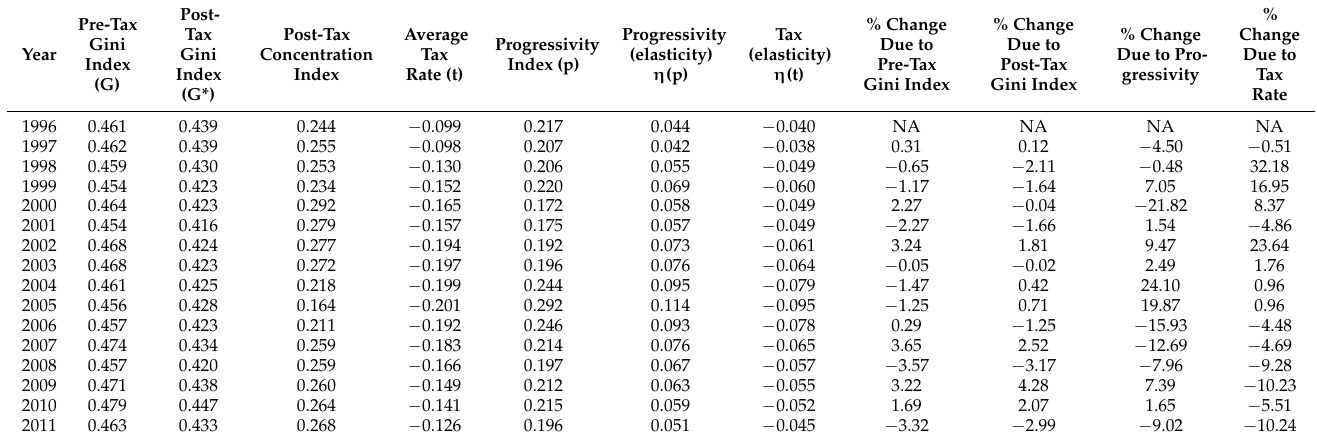
Table 3. Tax progressivity for female CPS respondents for years 1996 to 2011.